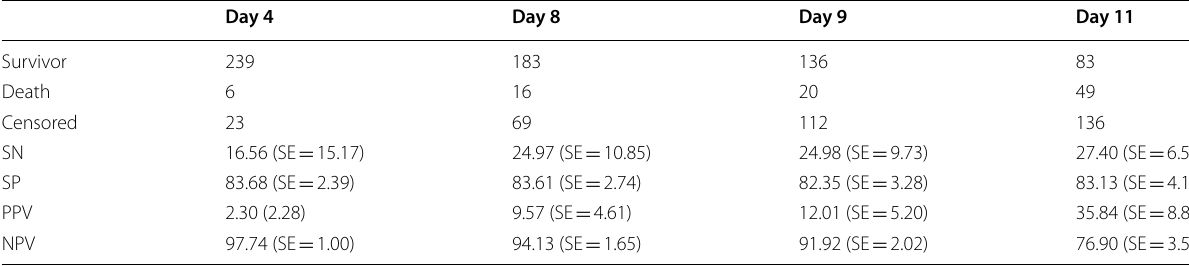
11,126 estimated using IPCW =